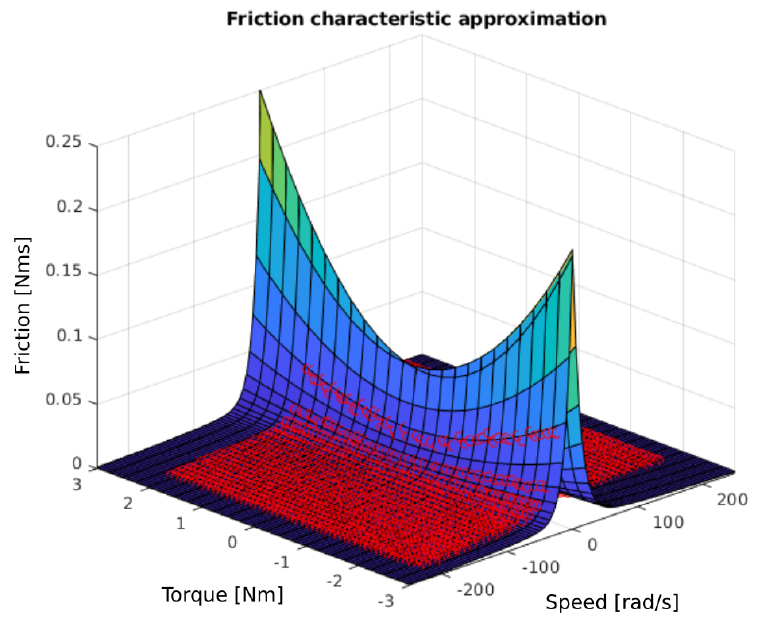
Figure 6. A comparison of the measured and approximated friction characteristics of the